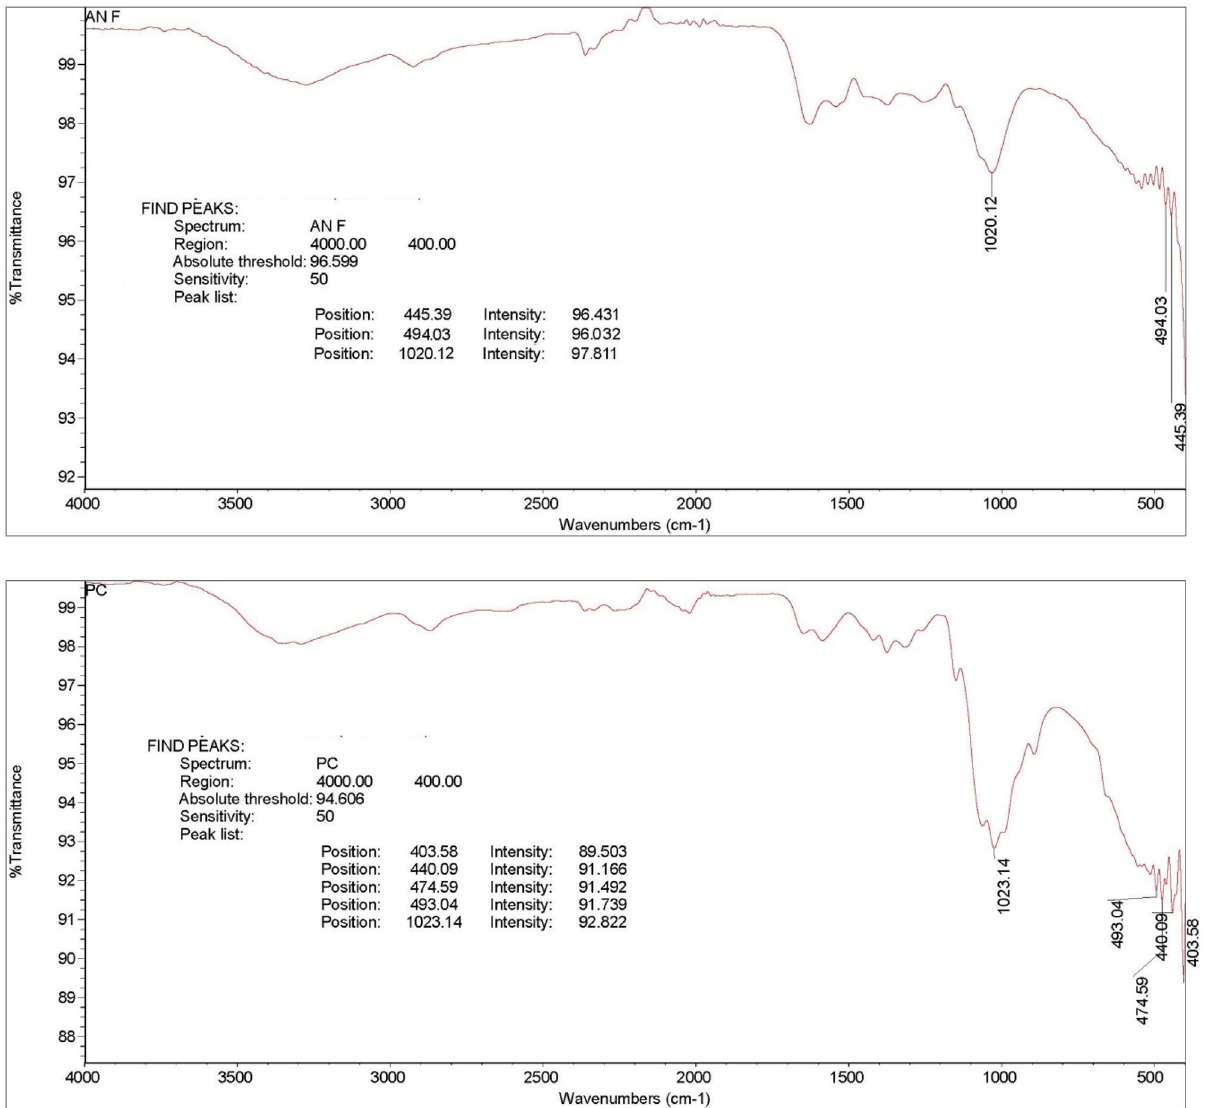
Figure 1. FT-IR spectra. ( A ) Fungal chitosan (FC); ( B ) product chitosan (PC). Similar stretches at wavelength at 3200–3400 cm −1 and 2850–3100 cm −1 shows the presence of OH and C–H in both PC and